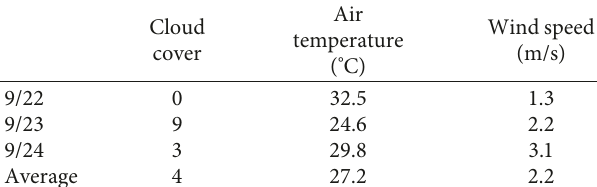
Table 3: Average weather data of Test